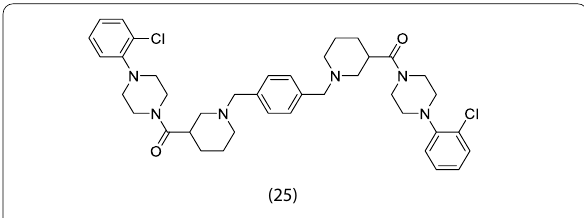
Fig. 30 Structure of chlorophenyl piperazinyl methanone piperidine derivatives